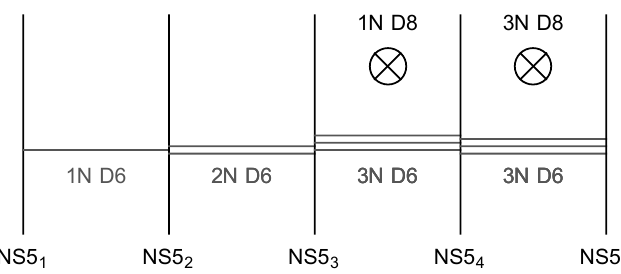
Figure 1. The Hanany-Witten set-up for the (cid:12)eld theory. The vertical lines denote individual Neveu-Schwarz branes extended on the ( x 4 ; x 5 ) space. The horizontal ones D6-branes, that